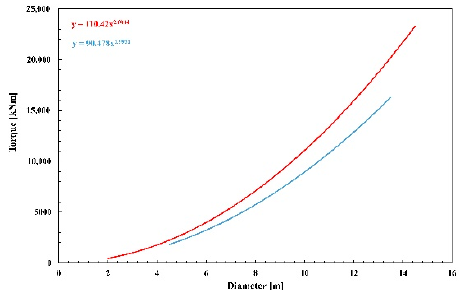
Figure 23. Trend of the torque vs. the diameter based on data collected from the analysis of single shield TBMs. In red, the experimental model proposed in this study; in blue, the model proposed by [42].